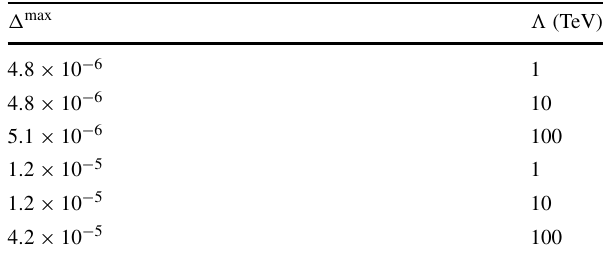
Table 9 Comparison between DSixTools and RGESolver . The first (last) three values refer to the approximate solution (numeric solu- tion)